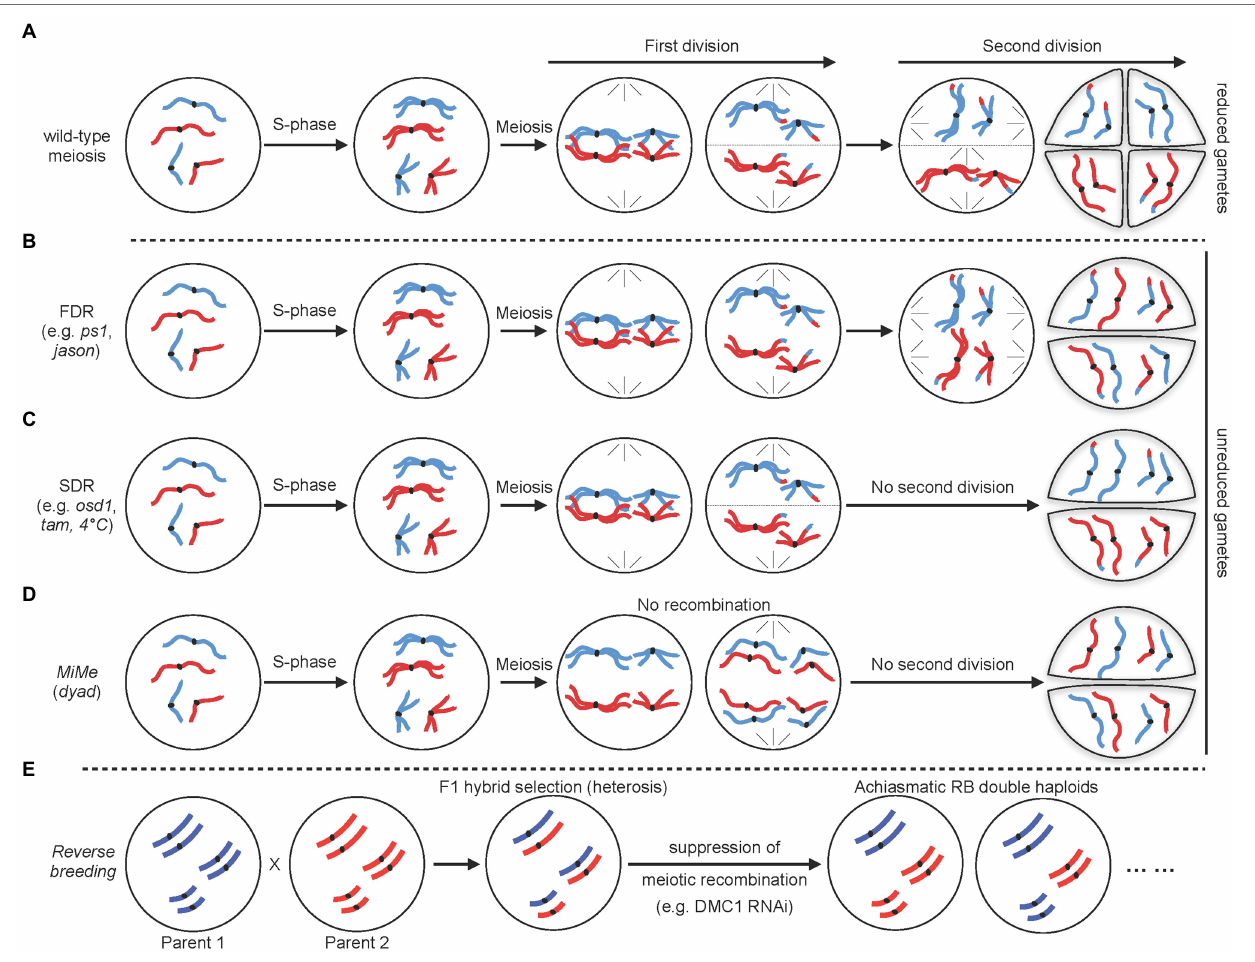
FIGURE 3 | Schematic representation of different strategies to remodel the meiotic division. (A) Normal meiotic division resulting in haploid (n) gametes. (B,C) Non- reductional meiotic divisions resulting in unreduced (2n) meiotic products. First division restitution (FDR; B ) and second division restitution (SDR; C ) lead to different levels of heterozygosity (see text for details). (D) Schematic diagram of apomeiosis obtained through MiMe strategy. (E) Reverse breeding strategy. For simplification, in each case, a diploid cell with only two chromosome pairs is shown with maternal and paternal chromosomes in red and blue,